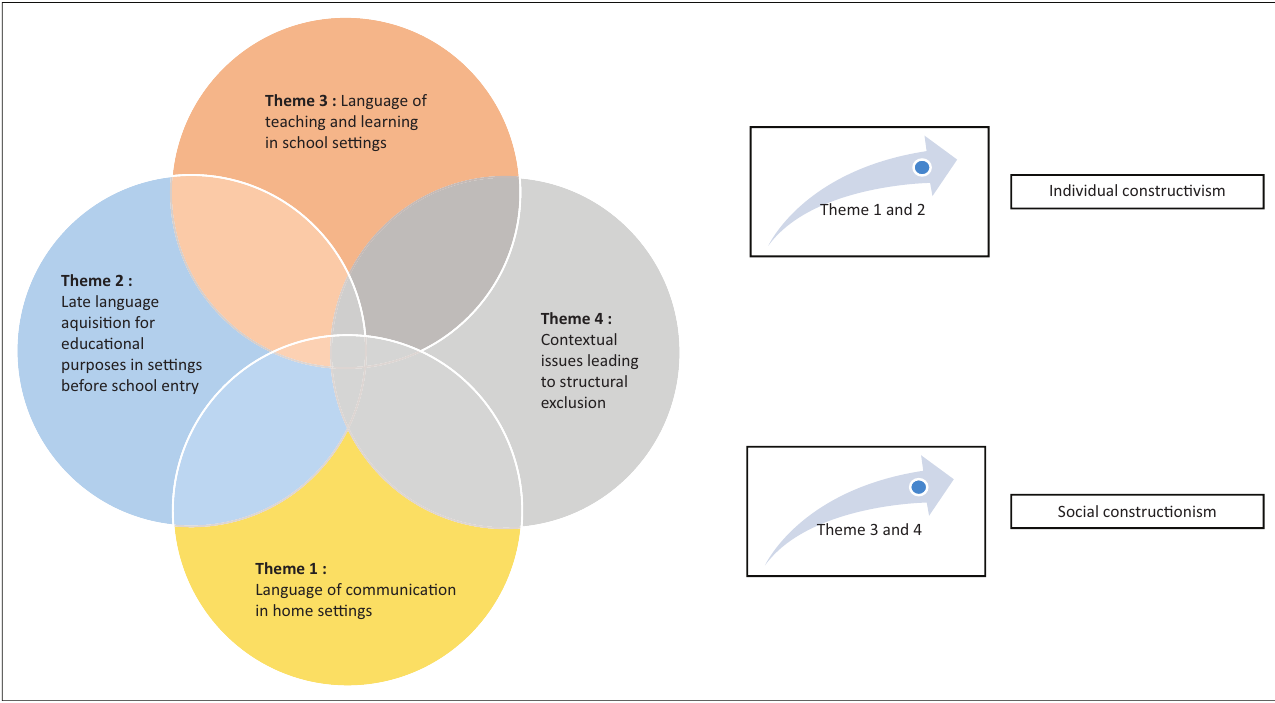
FIGURE 2 : The developmental links to the linguistic exclusion matrix.